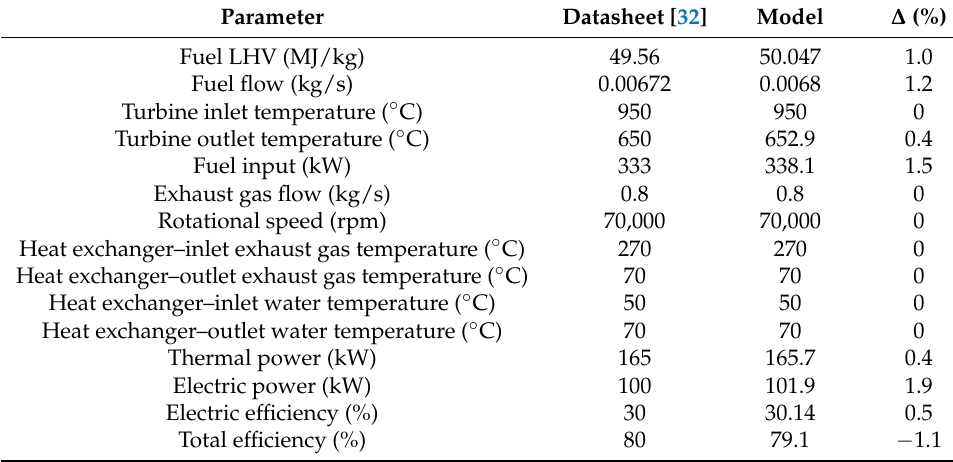
Table 3. Model validation at nominal